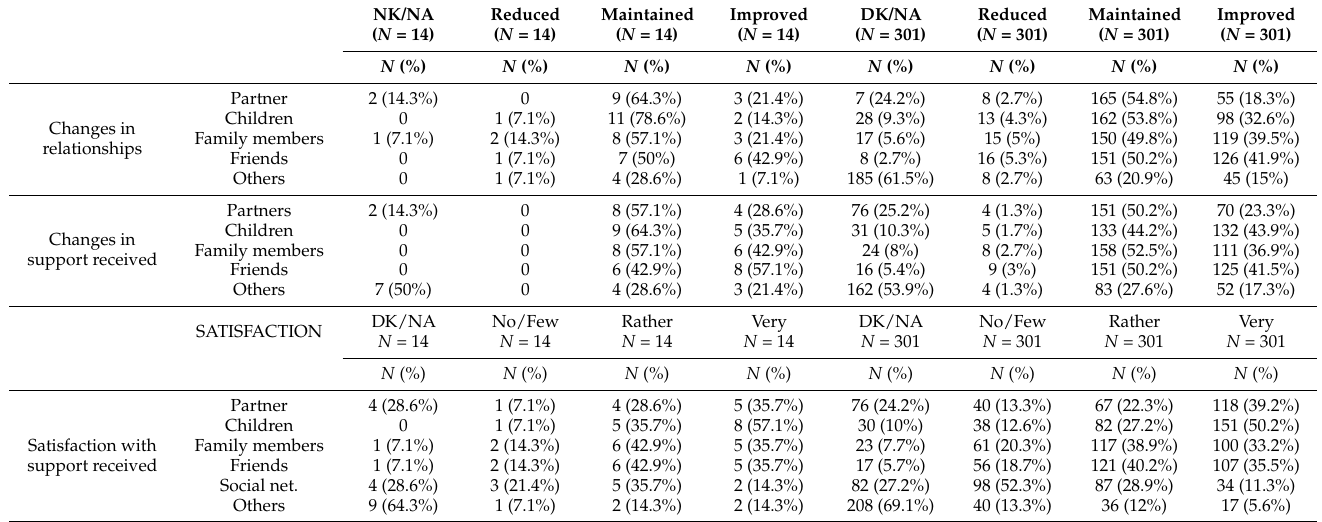
Table 5. Changes in family and social interaction, support received, and